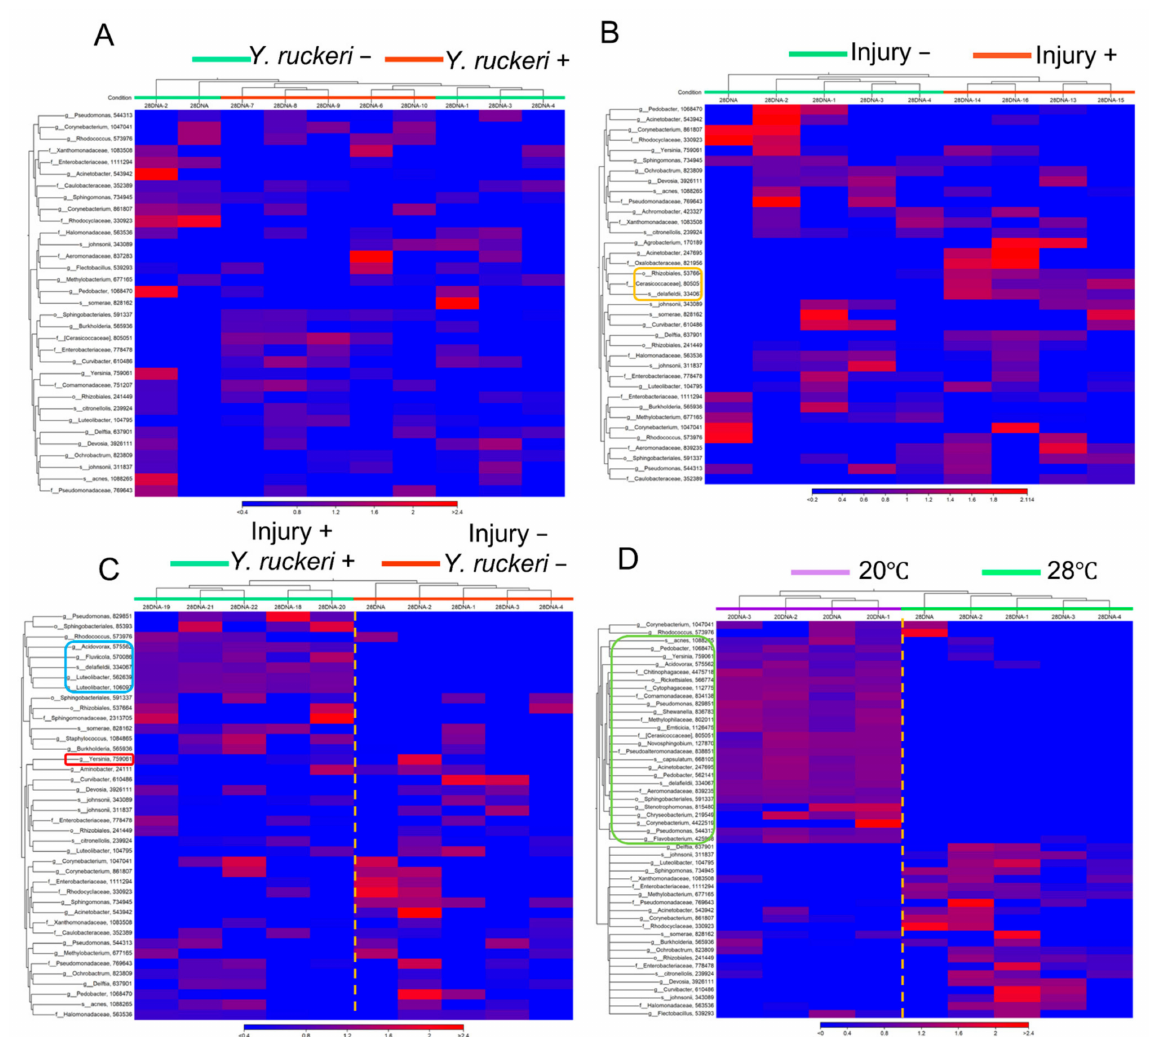
Figure 5. Heatmaps showing the relative abundances of OTUs (top 50) in skin bacterial floras. ( A ) Samples from fish with (injury − , Y. ruckeri +) or without pathogen challenge (injury − , Y. ruckeri − ) at 28 ◦ C without injury. ( B ) Samples from injured (injury+, Y. ruckeri − ) and uninjured fish (injury − , Y. ruckeri − ) at 28 ◦ C without pathogen challenge. An orange frame shows OTUs that increased following injury. ( C ) Samples from fish subjected to double manipulations of injury and pathogen challenge (injury+, Y. ruckeri +) and fish that were not subject to these manipulations (injury − , Y. ruckeri − ). Both groups of fish were maintained at 28 ◦ C. A blue frame shows OTUs increased by the double manipulations. A red frame shows the genus Yersinia . ( D ) Samples from fish maintained at 28 ◦ C and 20 ◦ C that were not subjected to either injury or pathogen challenge. A green frame shows OTUs increased at 20 ◦ C compared with 28 ◦